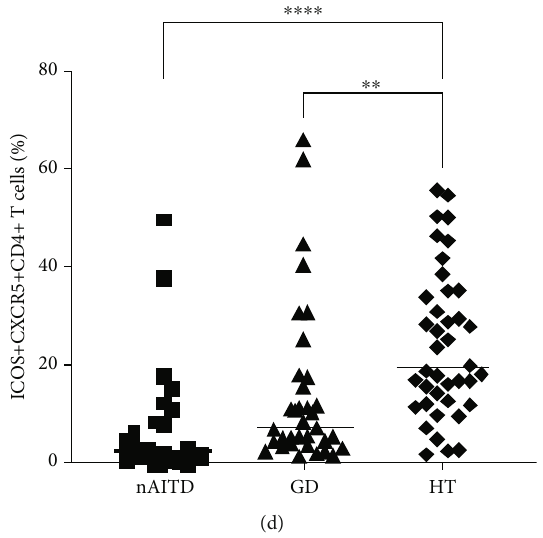
Figure 2: The frequencies of CD4 + CXCR5 + , CD4 + CXCR5 + PD-1 + , and CD4 + CXCR5 + ICOS high Tfh cells in the thyroid of GD and HT patients. (a) Representative dot plot showing the gating strategy for Tfh cells gated on CD4 + T cells. (b – d) The frequencies of CD4 + CXCR5 + , CD4 + CXCR5 + PD-1 + , and CD4 + CXCR5 + ICOS high Tfh cells in patients with GD ( n = 35 ), HT ( n = 40 ), and nAITD ( n = 22